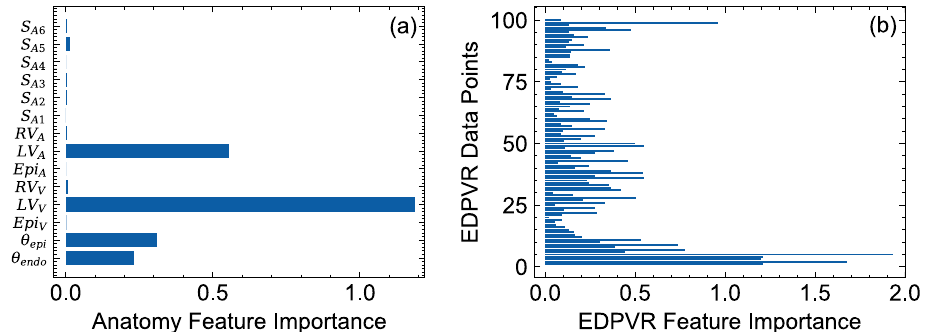
Figure 13. Permutation feature importance results for ( a ) geometric and fiber orientation features and ( b ) EDPVR features. EDPVR features consisted of 100 LV volume data points corresponding to the LV pressure values ranging from 0 to 30 mmHg with a fixed increment.